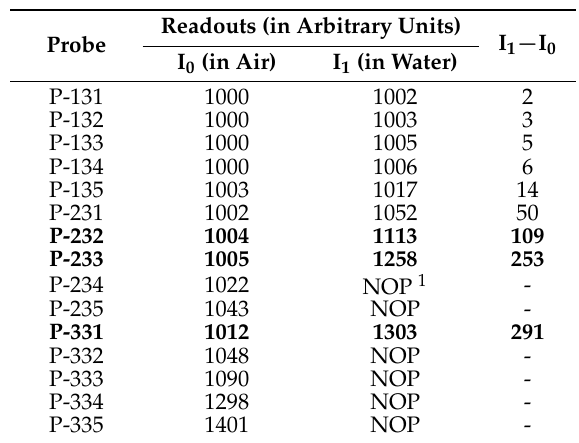
Table 1. Determining the best candidates for the sensor probes.